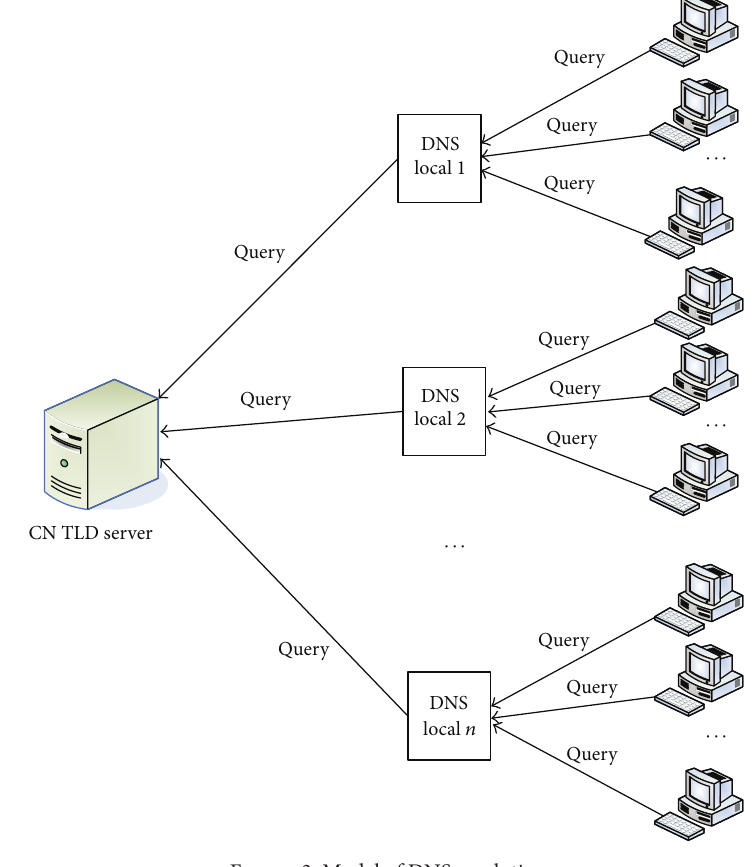
Figure 3: Model of DNS resolution.